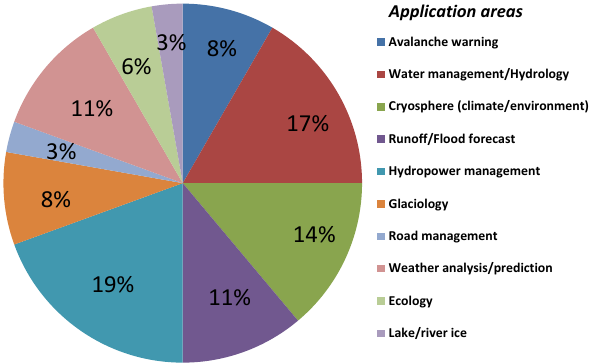
Figure 3. Application fields of